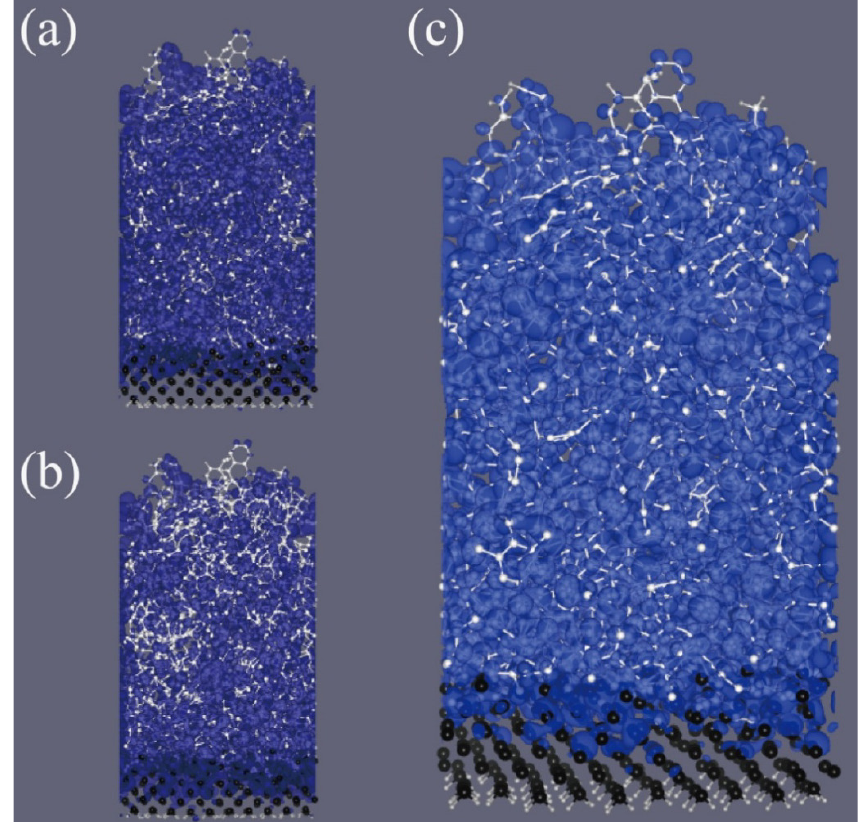
Figure 3. The moduli of wave function of ( a ) the highest occupied state and ( b ) the lowest unoccupied state of 1 eV-grown carbon film. Two wave functions are distributed in whole space of film. ( c ) The local density of states (LDOS) integrated over [ 0.1